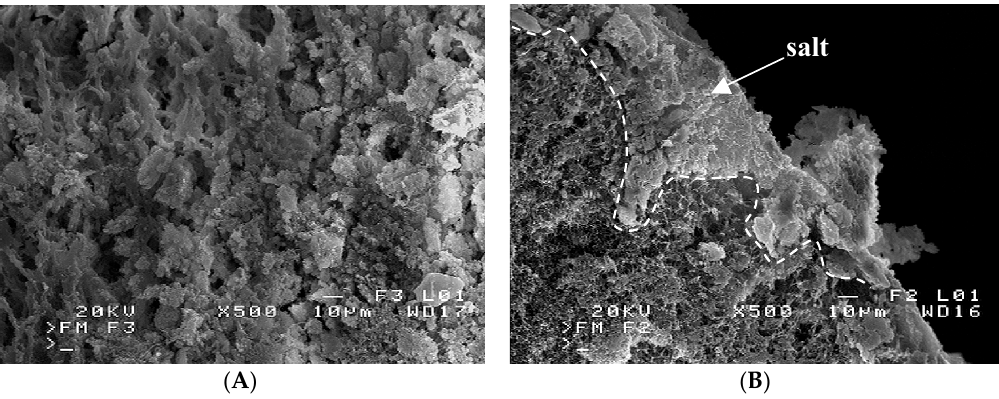
Figure 9. SEM images of salt deposits on: ( A ) membrane surface, ( B ) inside the membrane wall. Module MD2.